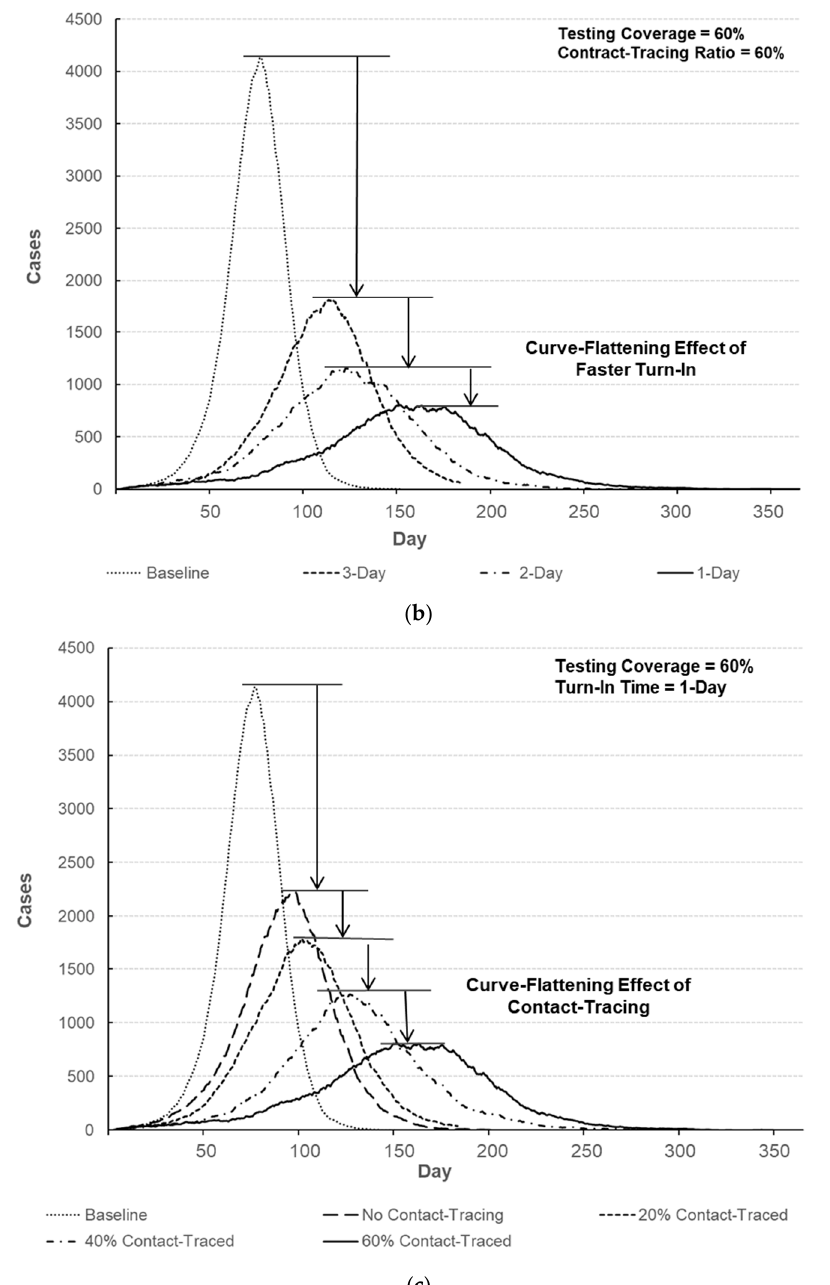
Figure 7. Comparison of the number of infected individuals over time. (a) Number of infected individuals for different testing coverages (turn-in time = 1-day, contact-tracing ratio = 60%). (b) Number of infected individuals with respect to turn-in time (testing coverage = 60%, contact-tracing ratio = 60%). (c) Number of infected individuals for different contact-tracing ratios (turn-in time = 1-day, testing coverage = 60%).